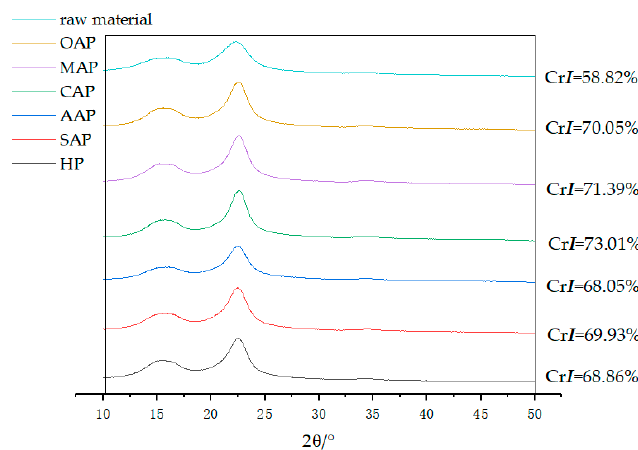
Figure 3. X-ray di ff ractometry (XRD) plots for raw material and pretreated eucalyptus. Figure 3. X-ray diffractometry (XRD) plots for raw material and pretreated eucalyptus. 3.3.